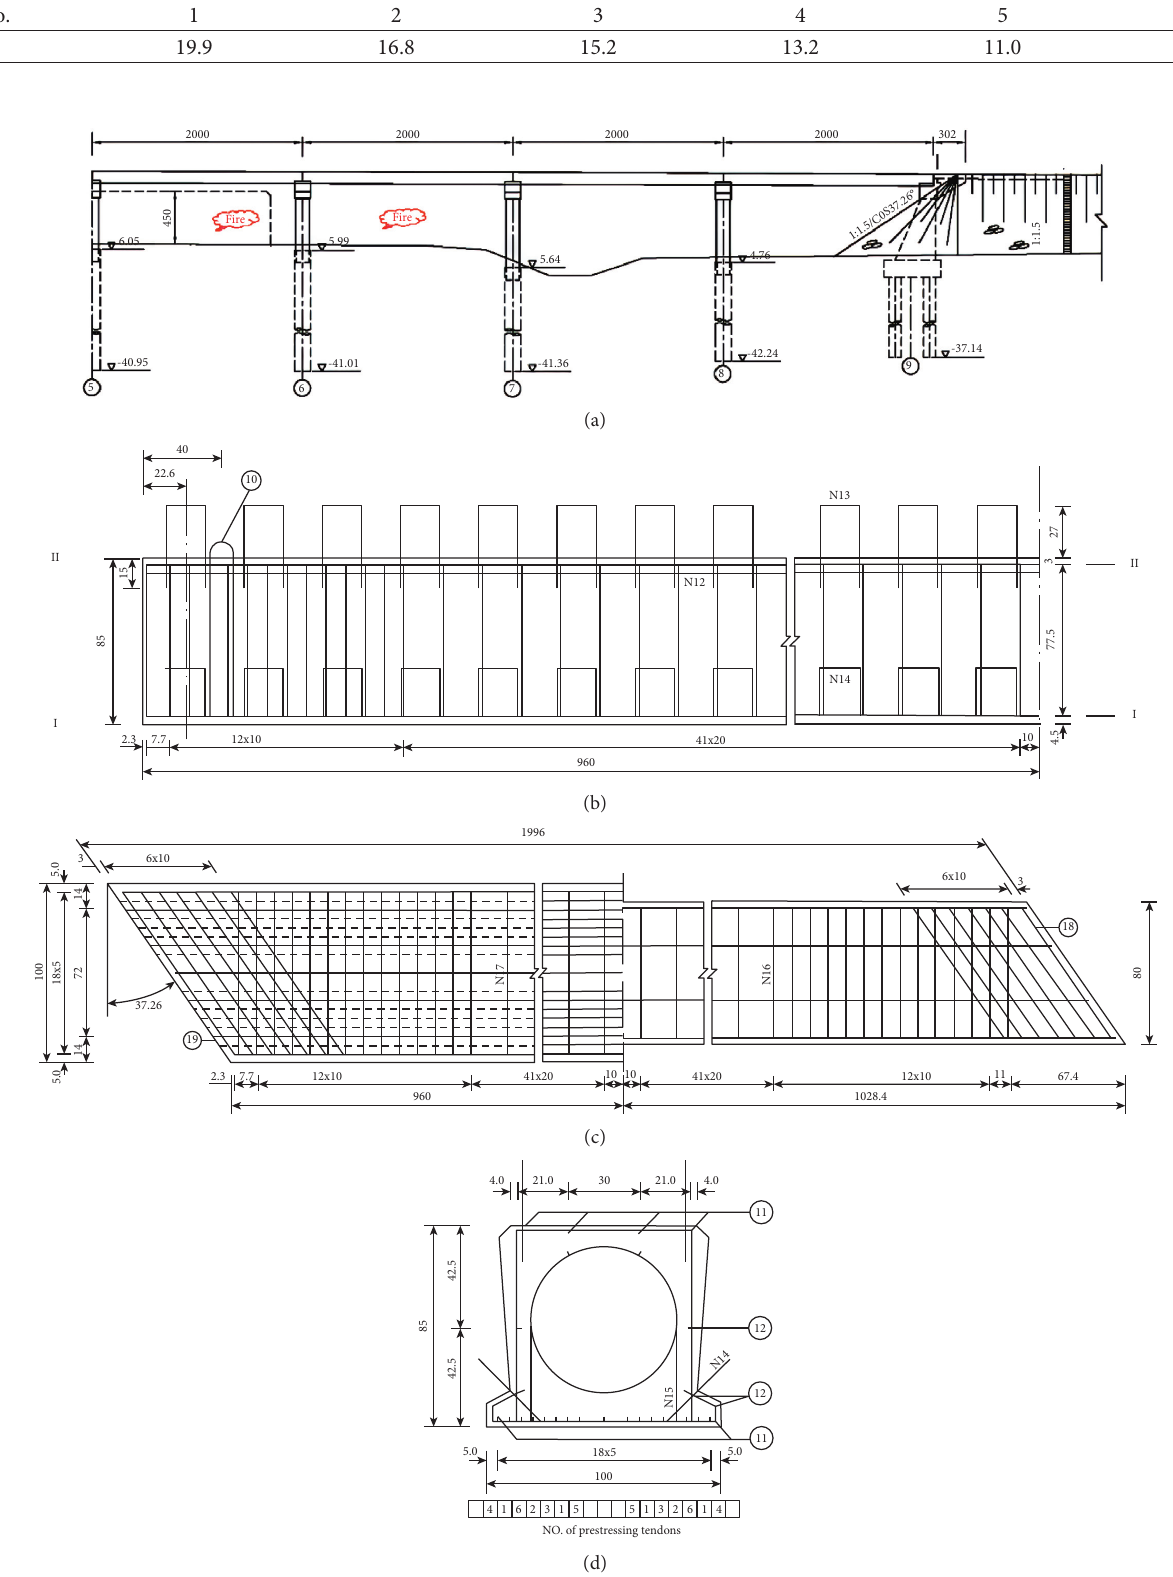
Figure 1: The elevation and reinforcement diagram. (a) Elevation (the unit of elevation is m, and the unit of span is cm). (b) Medium plate reinforcement diagram.